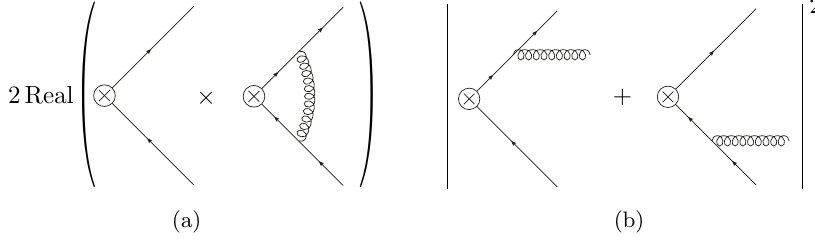
Figure 3 . Contributions to the O ( (cid:11) s ) di(cid:11)erential cross section for event shapes. Panel (a) shows the virtual contribution as twice the interference of the three-level and one one-loop diagrams, while in panel (b) the two real-radiation diagrams that have to be added and squared are